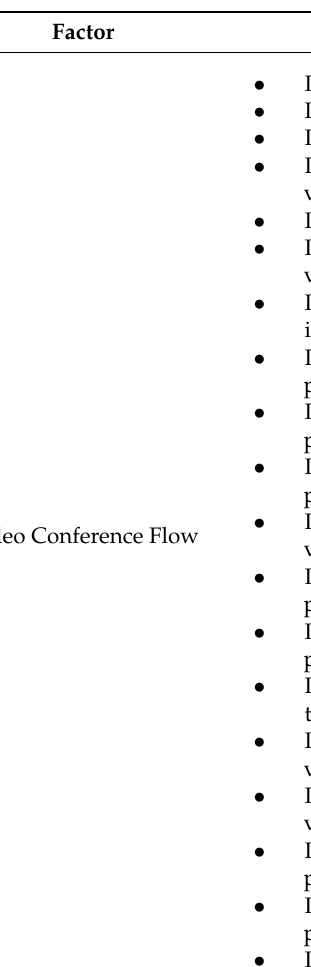
Table 4. Video conference